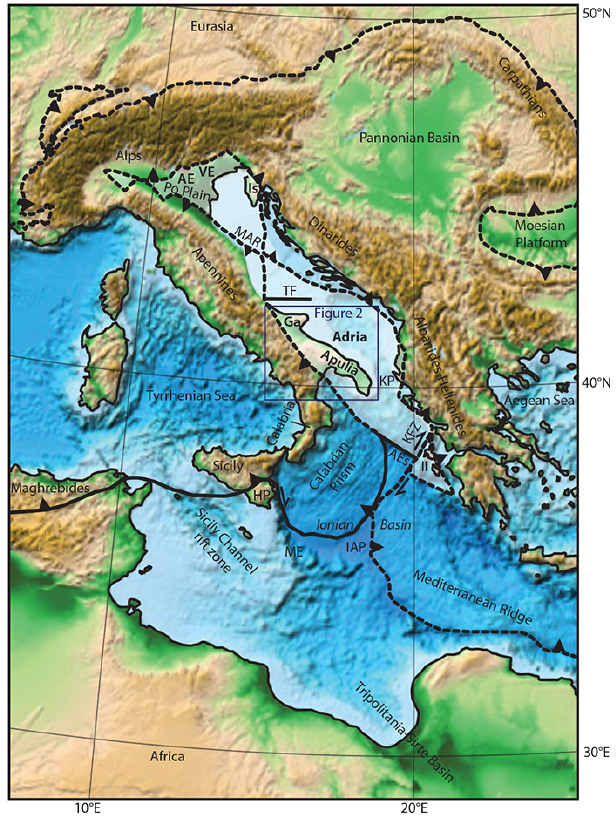
Figure 1. Regional tectonic map of the Mediterranean region. AE – Adige embayment; AEs – Apulian escarpment; Ga – Gargano;